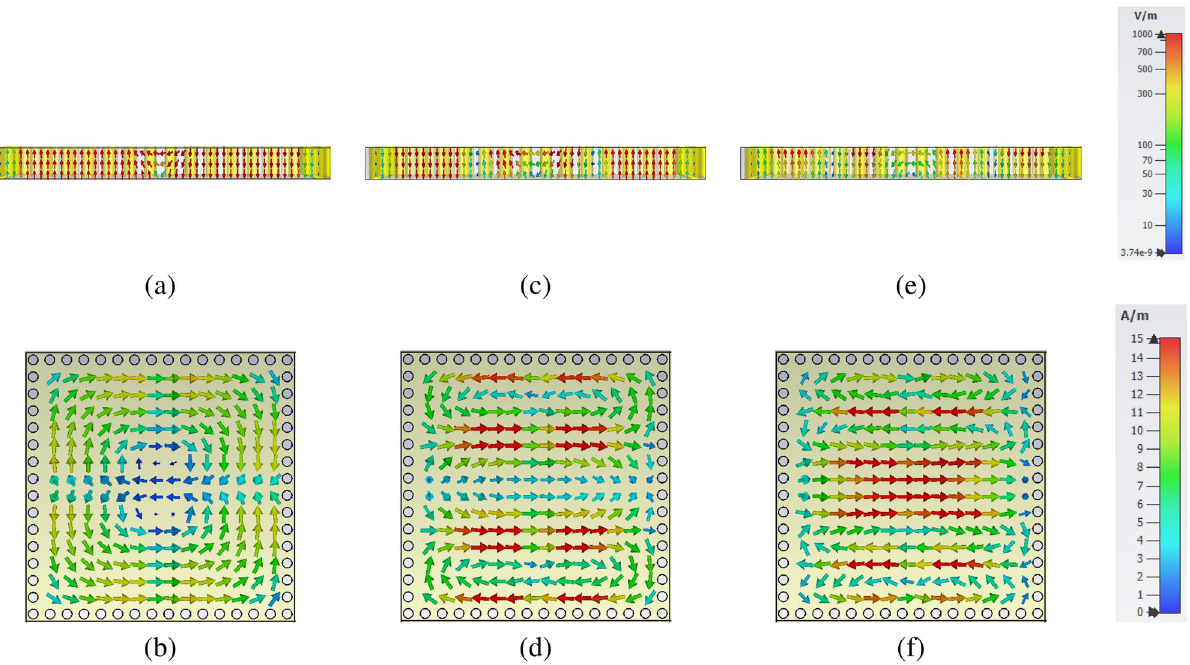
2.4 GHz = 5 GHz (Hybrid mode of =